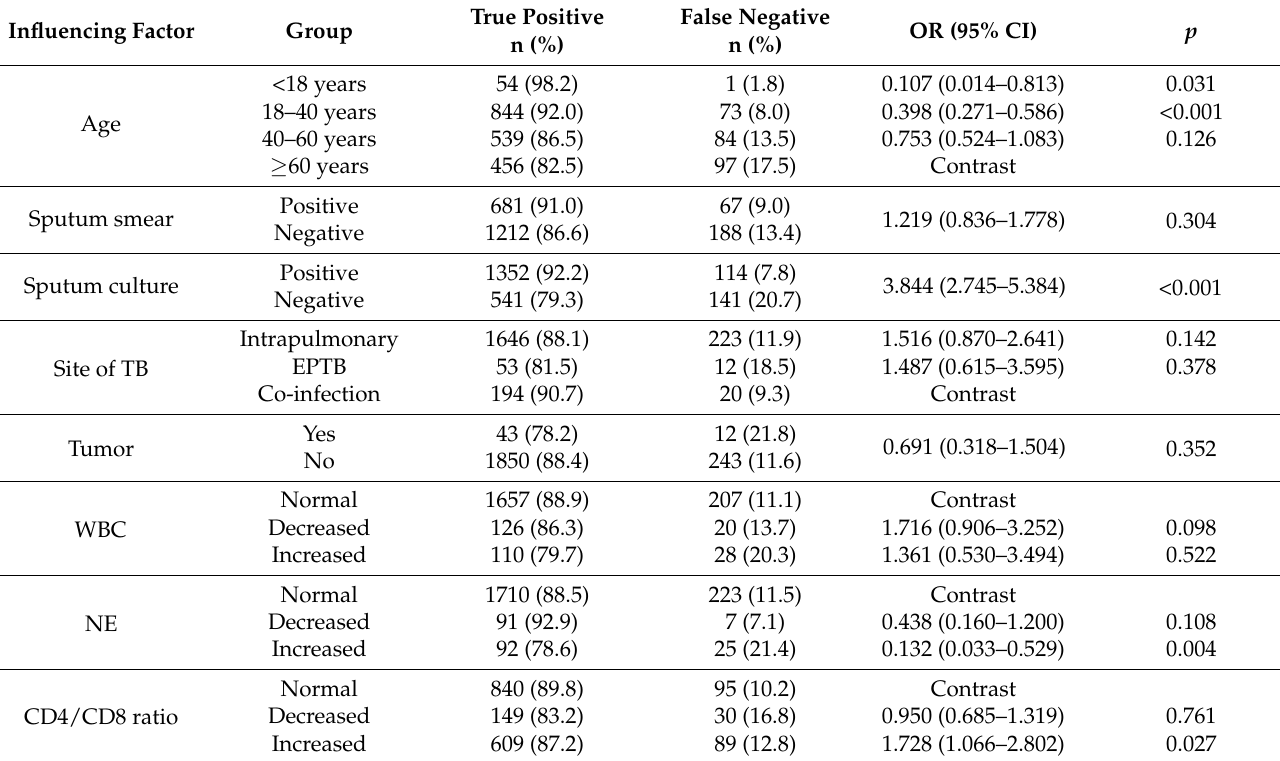
Table 3. Multivariate risk analysis of false-negative and true-positive QFT-GIT results in the diagnosis of active